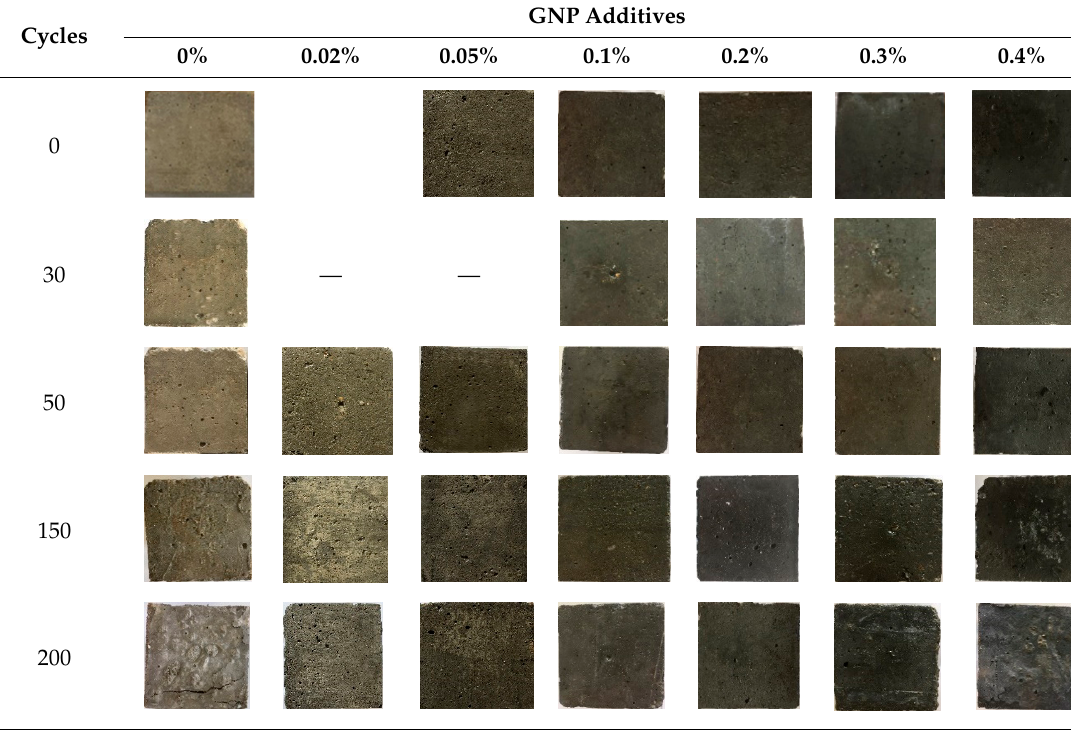
Table 2. Visual observations of GNP concrete at different F-T cycles.